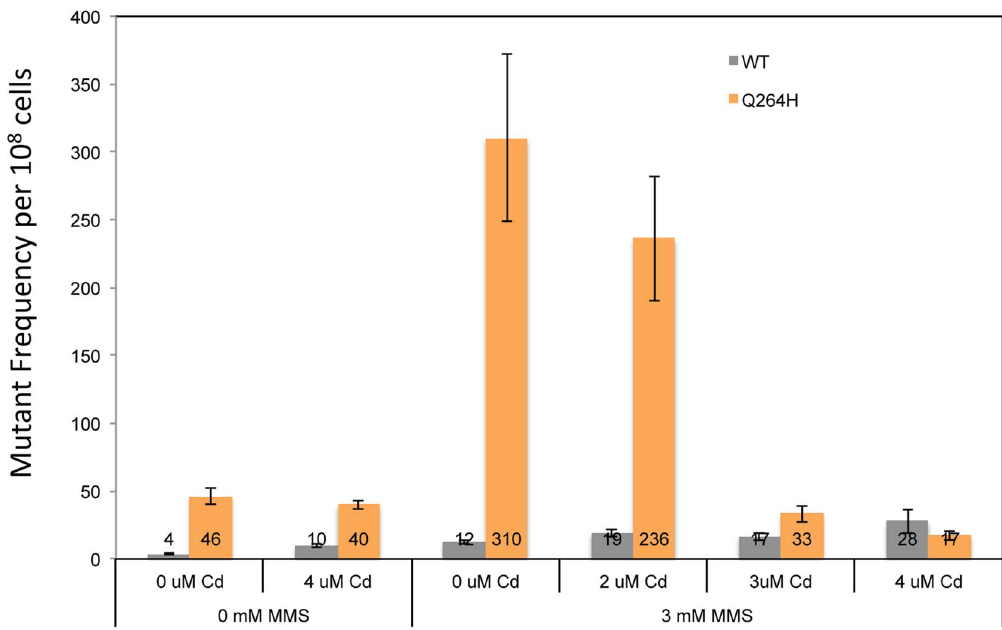
Figure 7. Exposure to CdCl 2 suppressed the MMS-induced increase in MtDNA mutant frequency. Median frequency ( 6 95% CI) of erythromycin-resistant mutants per 10 8 rho + cells of heterozygous diploid strains containing both a wild type MIP1 allele and a mip1 allele encoding the Q264H variant in the presence or absence of methyl methanesulfonate (0 or 3 mM) or CdCl 2 (0, 2, 3, or 4 m M). Mutant frequencies were determined from at least 20 different independent cultures. CI, confidence interval; MMS, methyl methanesulfonate, mtDNA, mitochondrial